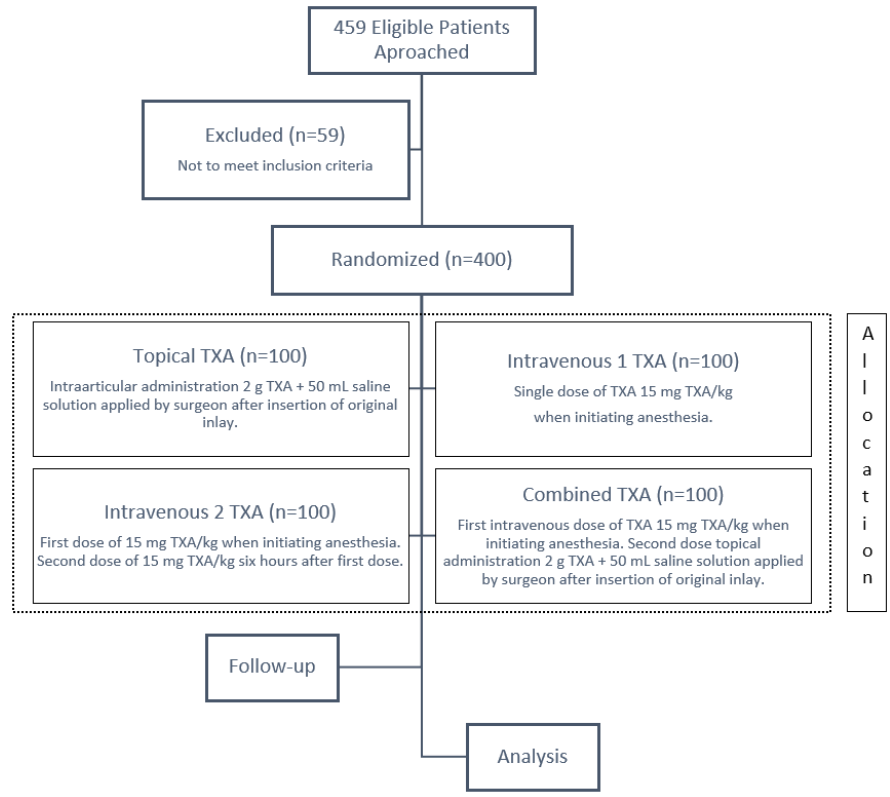
Fig. 1. Flow chart showing study subject identification, inclusion and exclusion, al- location and protocols of